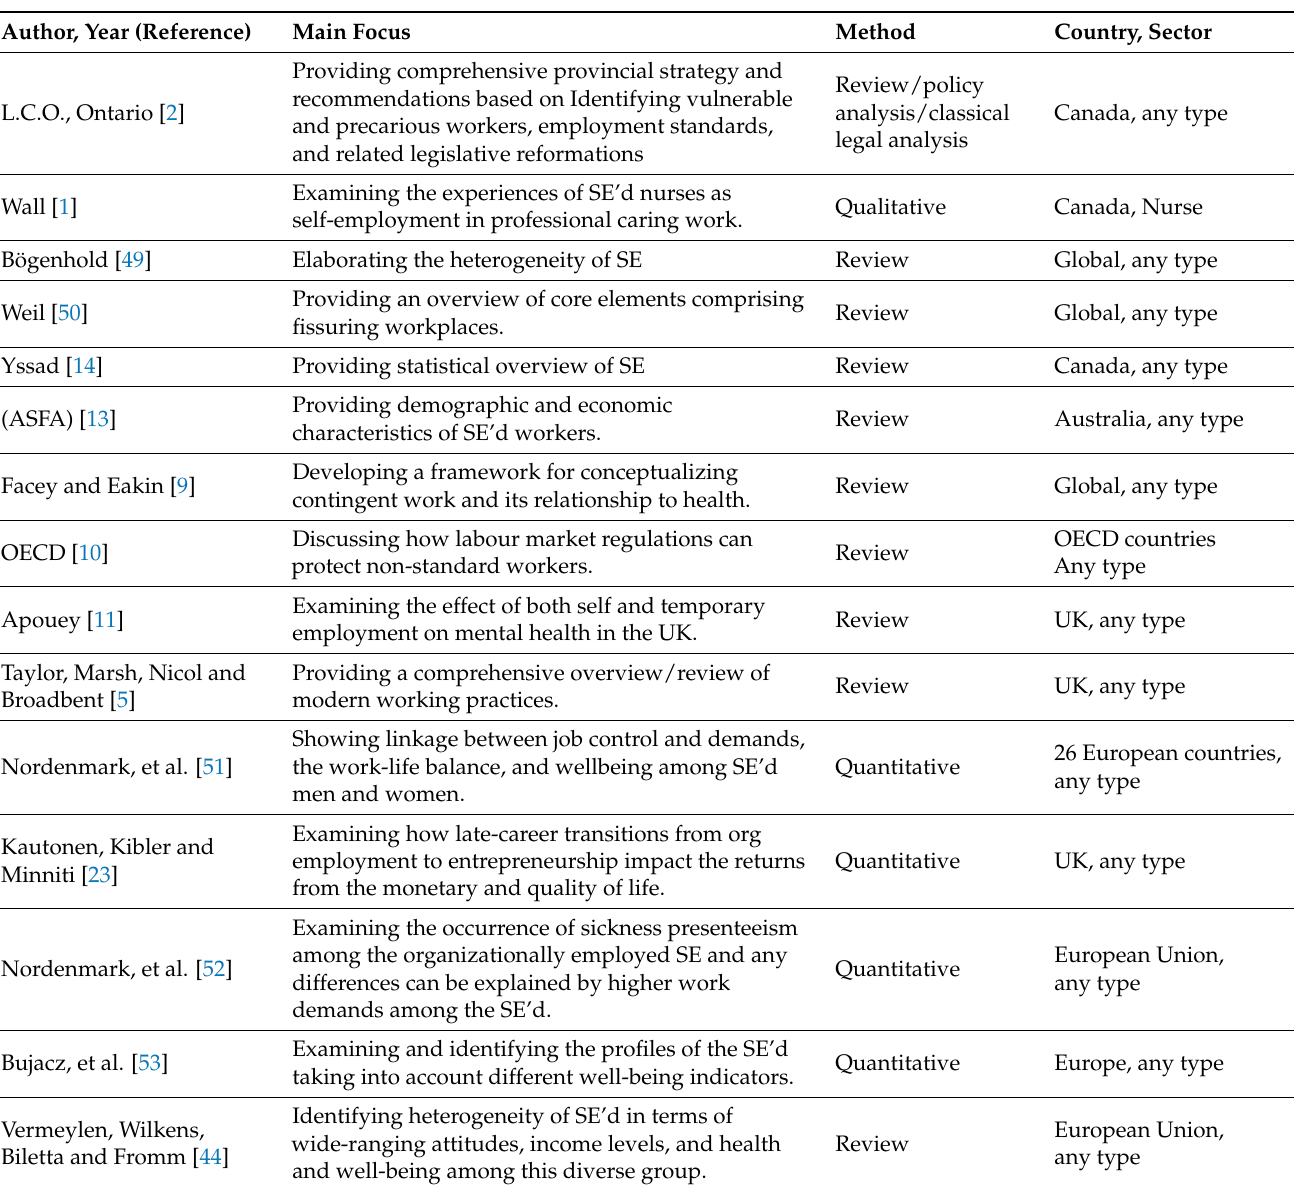
Table 1. Description of literature identified by the non-systematic